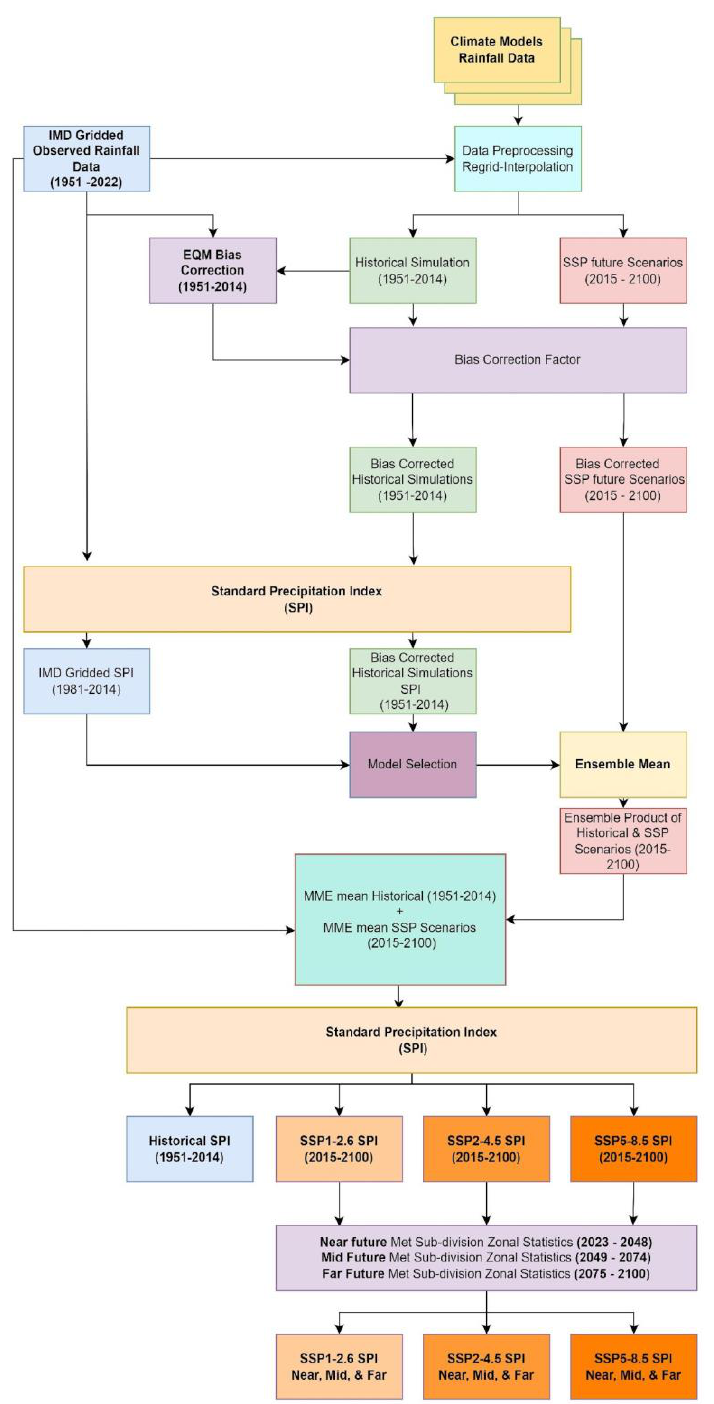
Figure 3. Flow chart of the designed investigation.